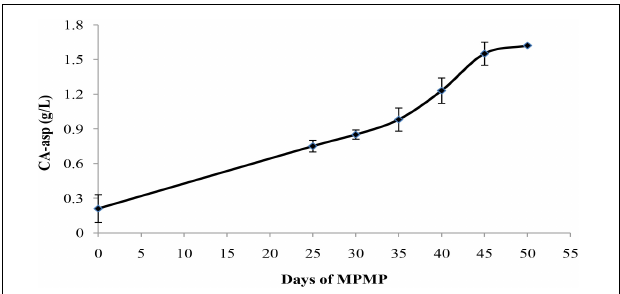
FIGURE 9 | N -carbamoyl- L -aspartate (CA-asp) content in mycelia collected at different MPMP